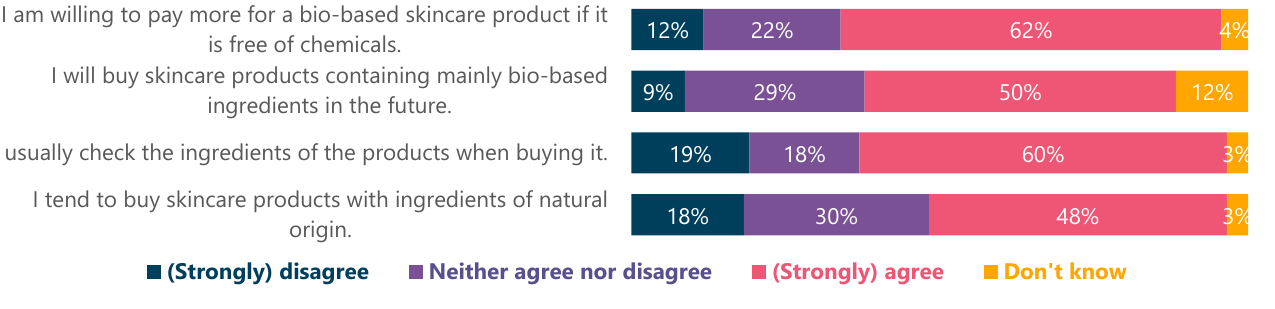
Figure 6. Buying related items with answer distribution from highest to lowest level of agreement. Respondents also ranked various attributes of sunscreens by their importance when deciding to buy the product. The most important deciding factors were quality, price, and texture, closely followed by natural ingredients (Figure 7). The least important qualities of sunscreens were their novelty, color, and packaging.